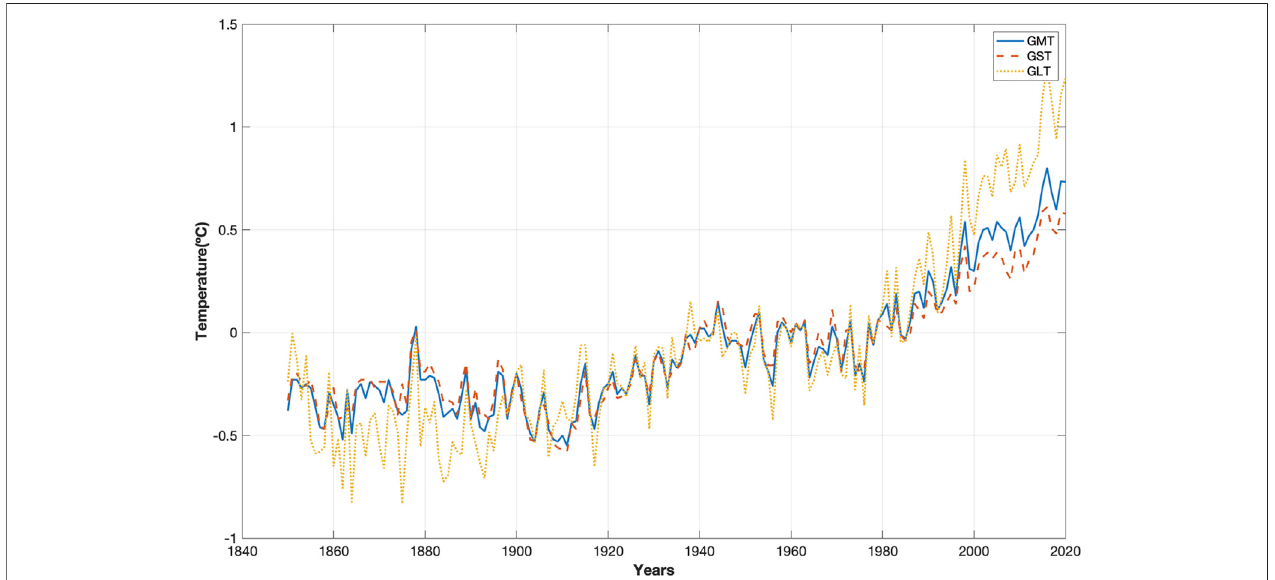
FIGURE 2 | Earth ’ s global mean temperature, (GMT), (HadCRUT4), global sea surface mean temperature, (GST), (HadSST3) and global land surface mean temperature, (GLT), (CRUTEM4) from 1850 to 2020 (Climate Research Unit).